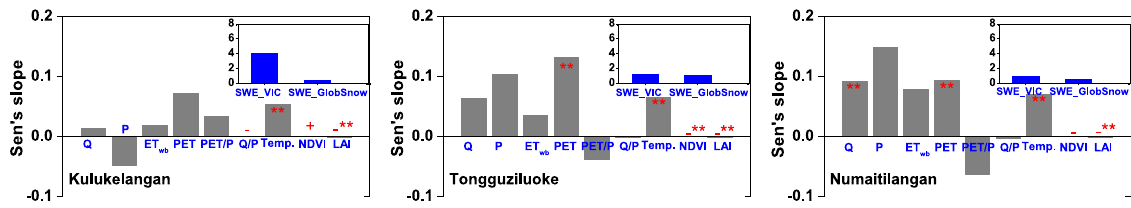
Figure 8. Sen’s slopes of water budget components and vegetation parameters in westerlies-dominated TP basins during the period of 1982– 2011. To clearly exhibit the non-parametric trends of all variables in one panel, the Sen’s Slopes of Q , P , ET wb and PET have been multiplied by 1 / 12 (unit: mmmonth − 1 ). The double red stars showed that the trend was statistically significant at the 0.05 level.